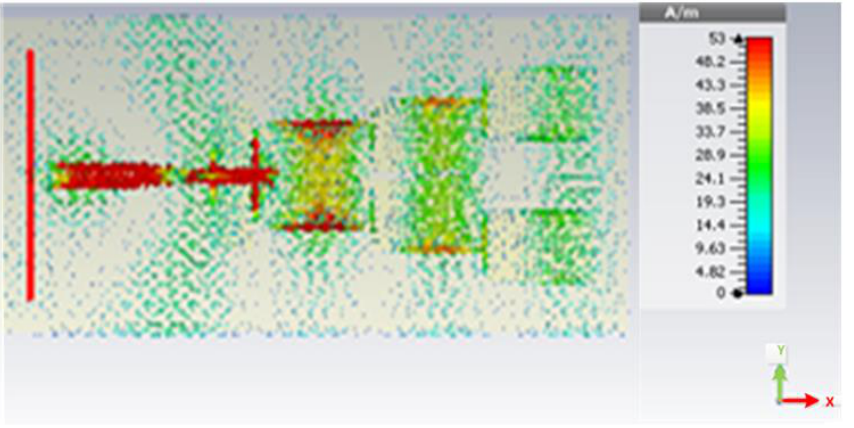
Figure 7. Surface current distribution with S2 parameter.